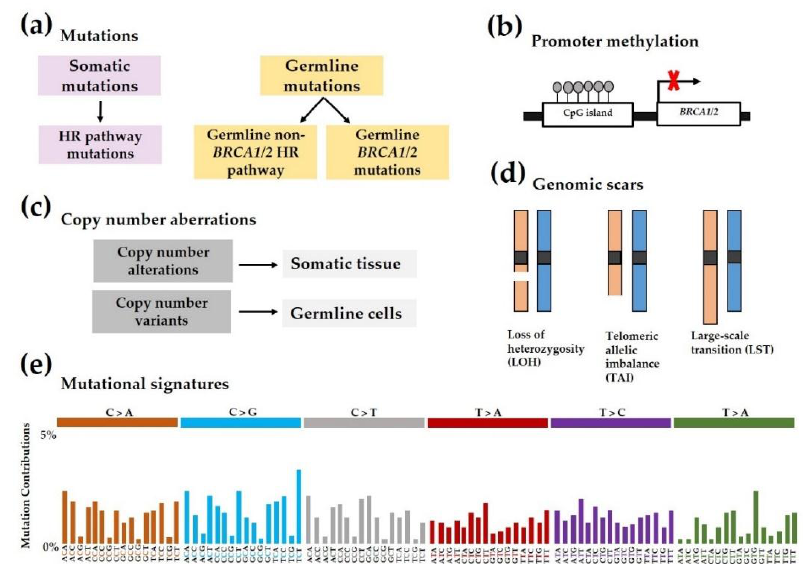
Figure 2. Homologous recombination deficiency (HRD) and genomic alterations. ( a ) Both